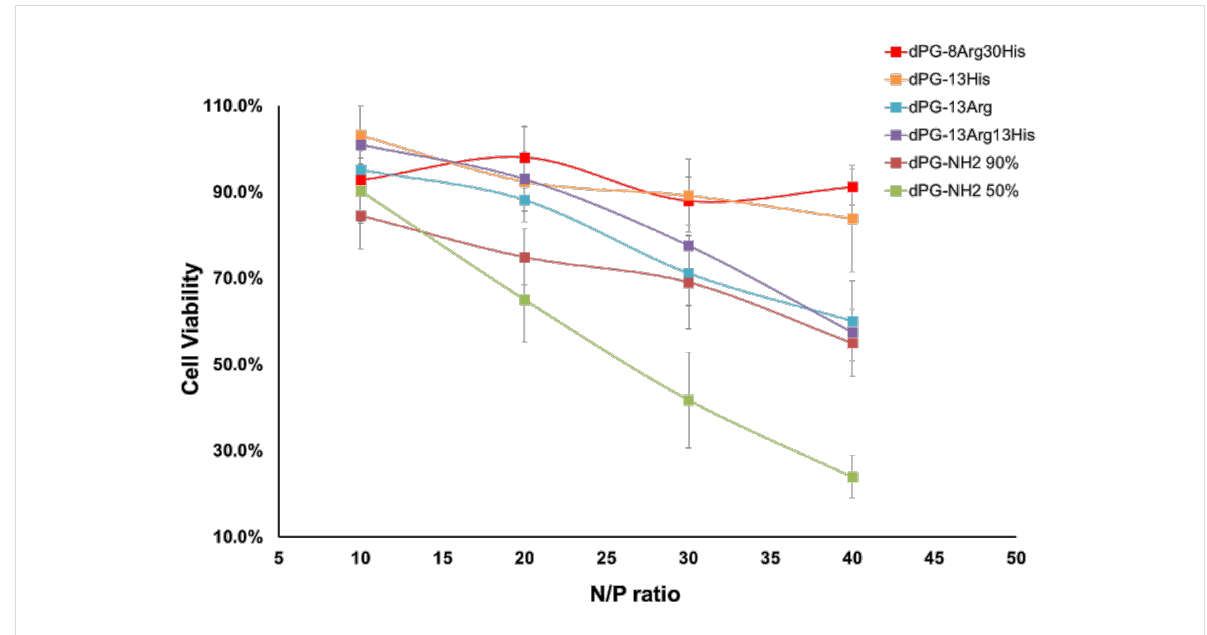
Figure 3: The result of MTT assay on a NIH 3T3 cell line transfected with AAdPG, dPG-NH 2 50%, and 90%/siRNA polyplexes at different N/P ratios with 100 nM siRNA concentration.